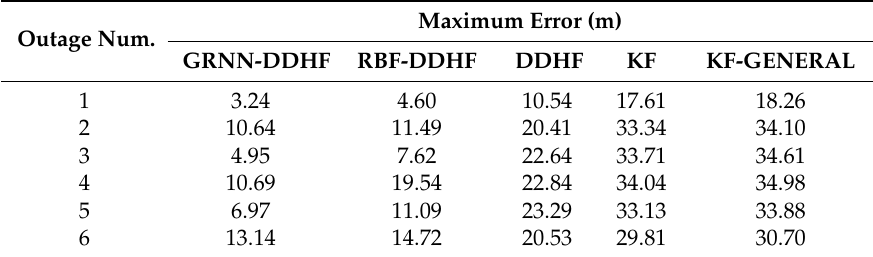
Table 4. Maximum position errors during GPS outages for Trajectory 1 with extra simulated uncertain nonlinear drift.